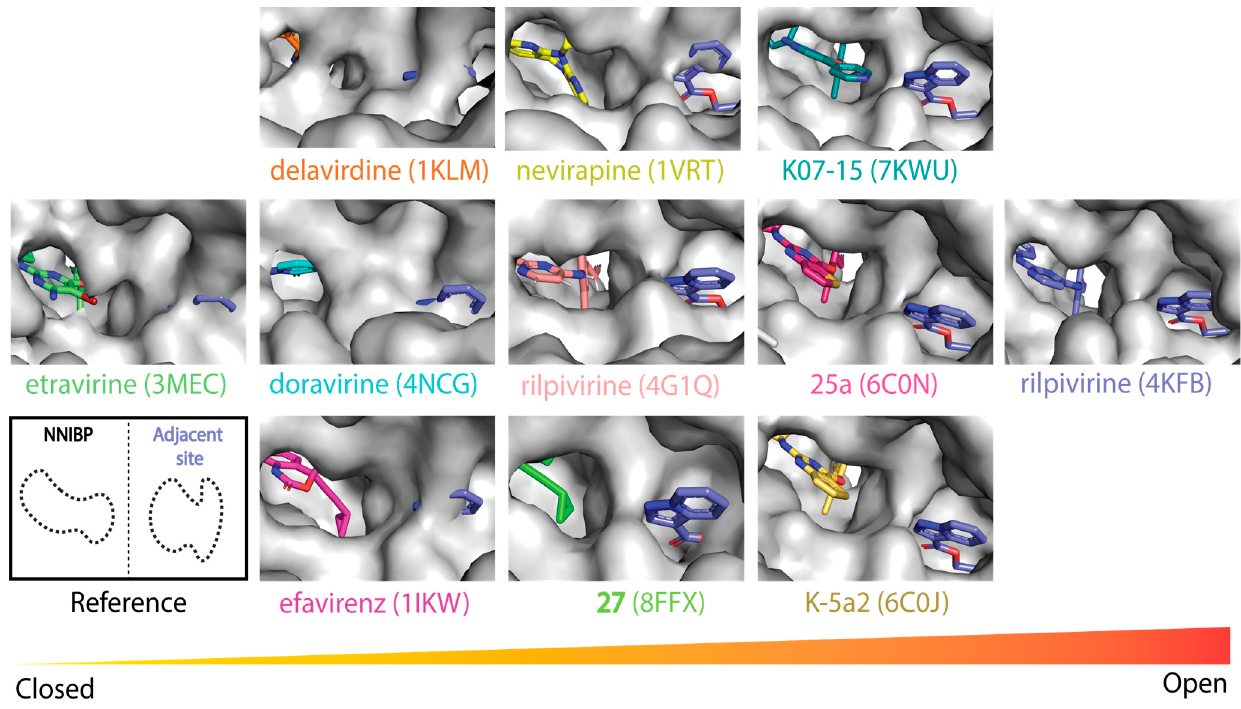
Figure 5. Surface representations of the NNIBP and NNRTI Adjacent sites with approved NNRTIs and investigational inhibitors. The compactness of the NNRTI Adjacent site in structures decreases from left to right (closed to open). NNRTIs and their protein bound structures are indicated in each panel, with their PDB ID in parenthesis. Lead compound B-1 (purple) is superimposed in the NNRTI Adjacent site (right). Compound in the NNRTI site are shown in a range of colors. Nitrogen atoms are blue and oxygen atoms are red.